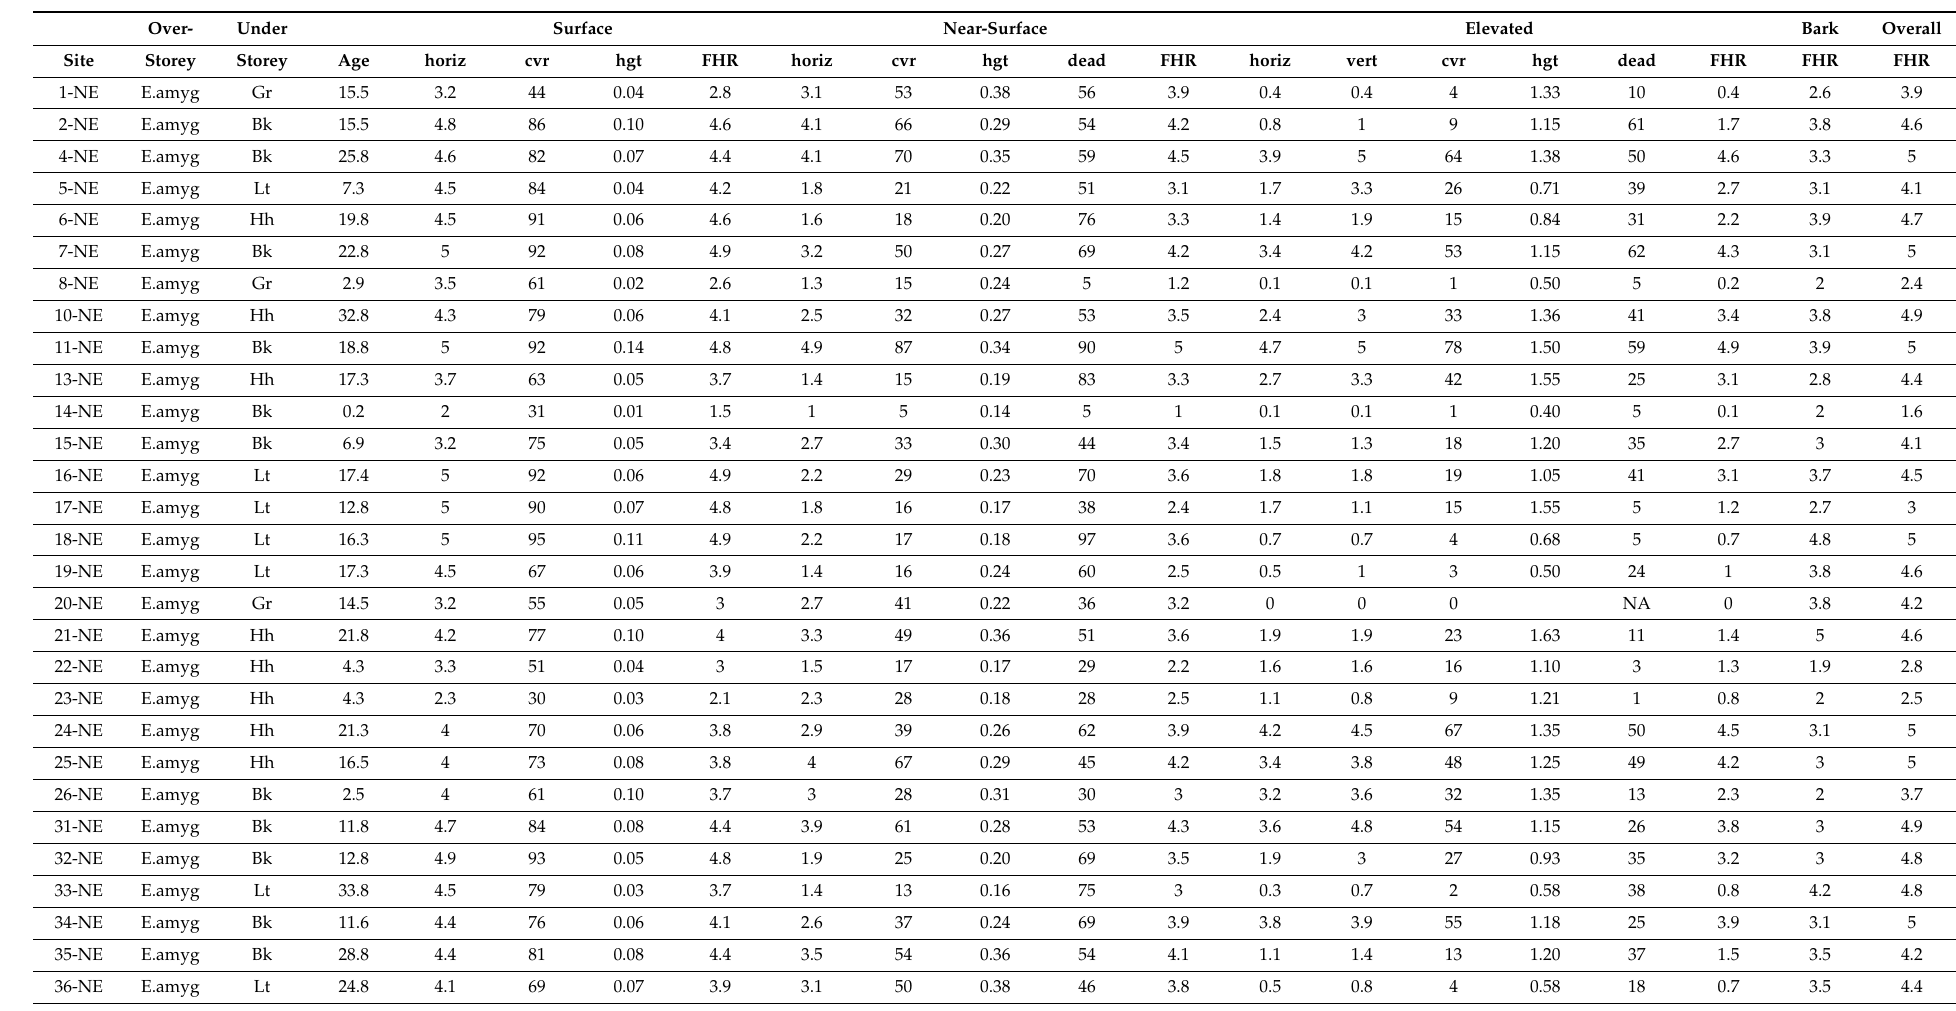
Table A3. Fuel Hazard Rating Data from Tasmanian Dry